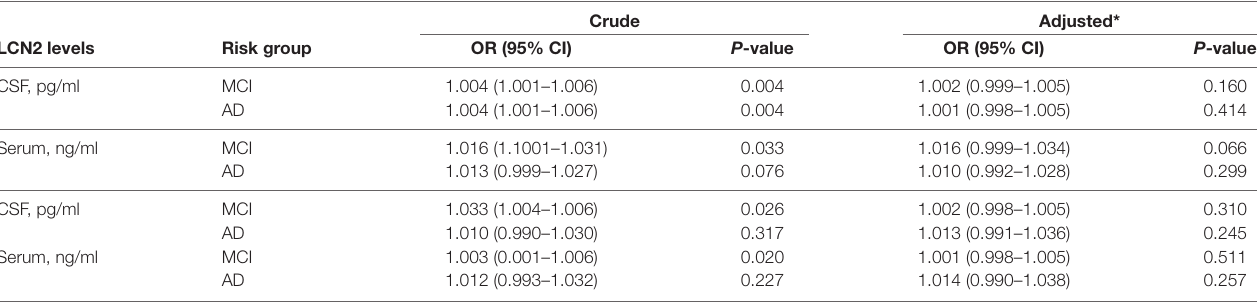
TABLE 3 | Crude and adjusted OR with 95% CI from multinomial logistic regression for the probability of having cognitive impairment (AD or MCI) using SCC as reference group for the Swedish